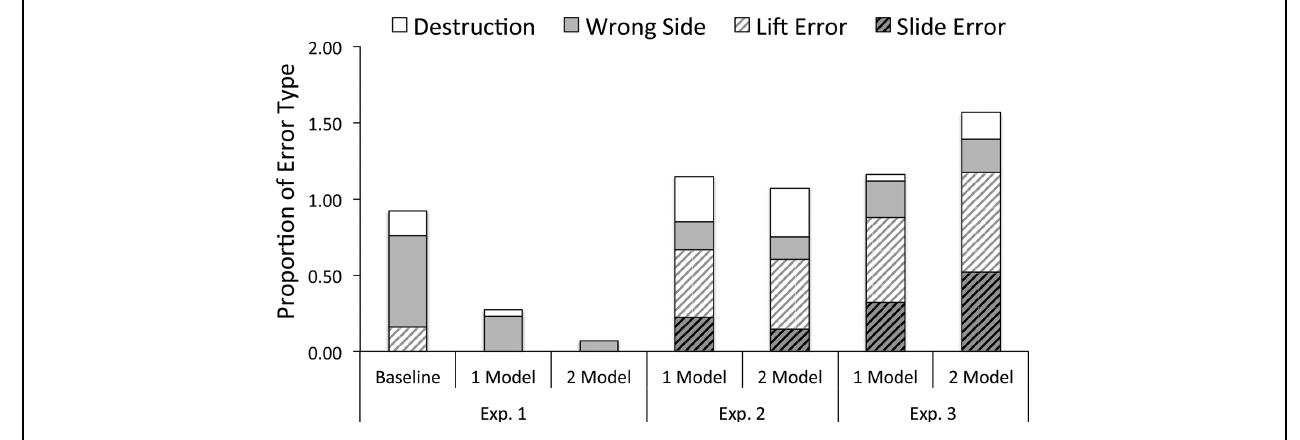
FIGURE 3 | Summary of error types by condition and